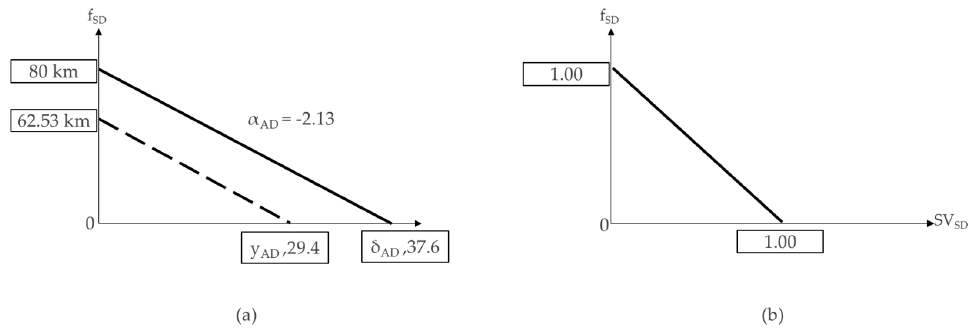
Figure 17. Adjustment factor development ( a ) and standardization for the existence ( b ) of the num-